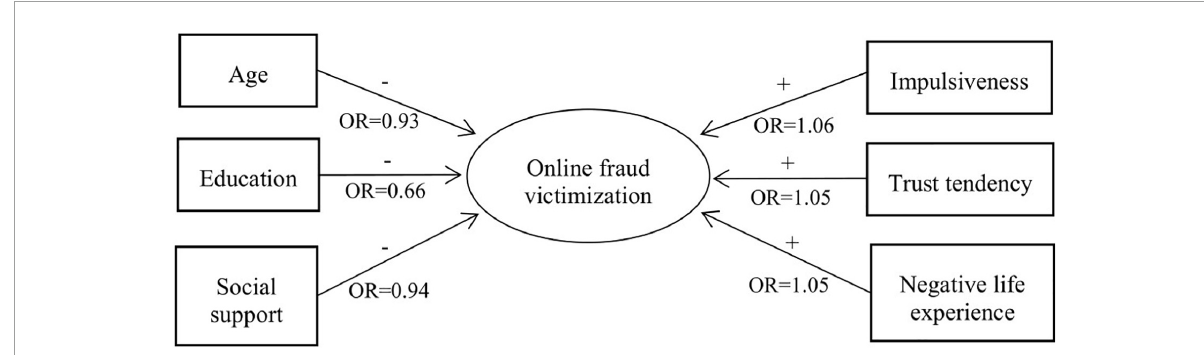
FIGURE1 The predictive effects of the measured variables on online fraud victimization. OR, odds